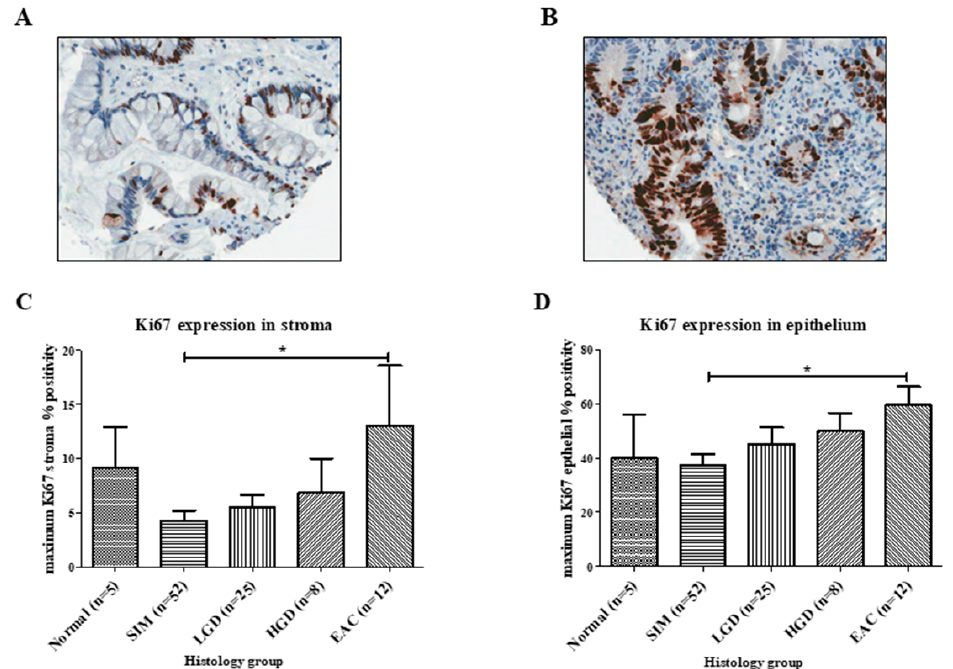
Figure 3. Ki67 staining across the Barrett’s esophagus disease spectrum. ( A ) Section of a core of Barrett’s intestinal metaplasia, at magnification 40 × , demonstrating no staining of stroma and approximately 40% epithelial staining. ( B ) Section of a core of esophageal adenocarcinoma, at magnification 40 × , demonstrating approximately 75% Ki67 staining in the glandular epithelium. Ki67 staining was significantly increased in the ( C ) stroma and ( D ) epithelial cells of esophageal adenocarcinoma patients compared with SIM patients. Error bars represent SEM. * p < 0.05.